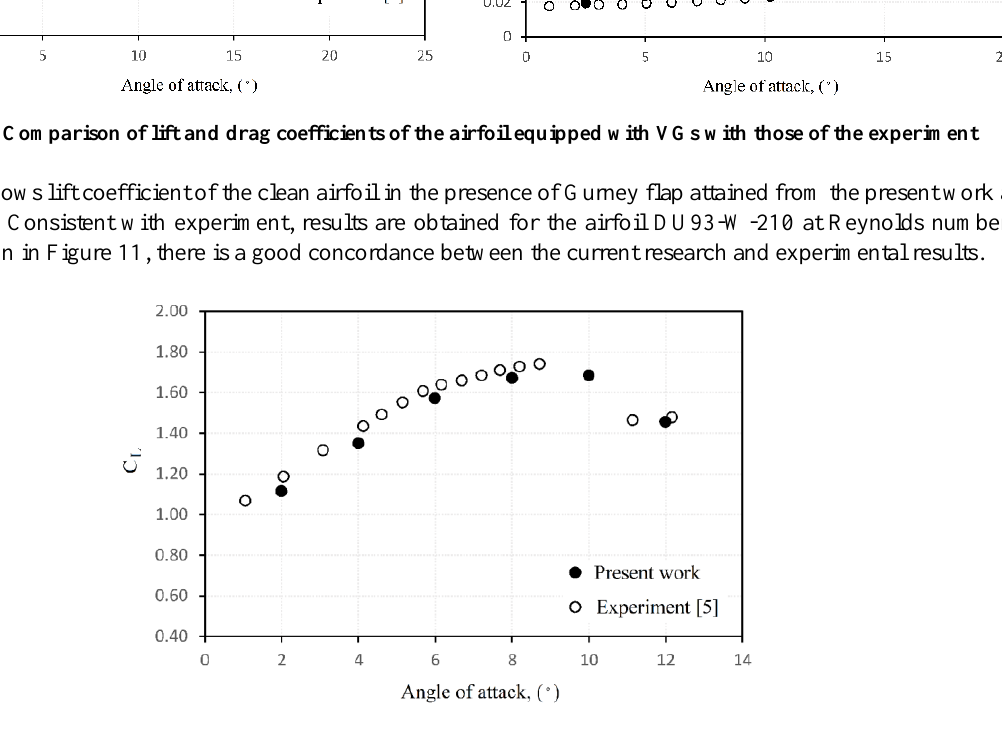
Figure 11. Lift coefficient of the clean airfoil in the presence of Gurney flap attained form the present work and experiment Our numerical results also reveals that for the clean airfoil DU93-W-210 in the presence of trailing-edge wedge, the maximum lift to drag ratio at Reynolds number of 2×10 6 is 117.3. Referring to the work conducted by Timmer and Rooij [5], one could see that the maximum lift to drag ratio is reported to be 125.1, which is close to that of the present